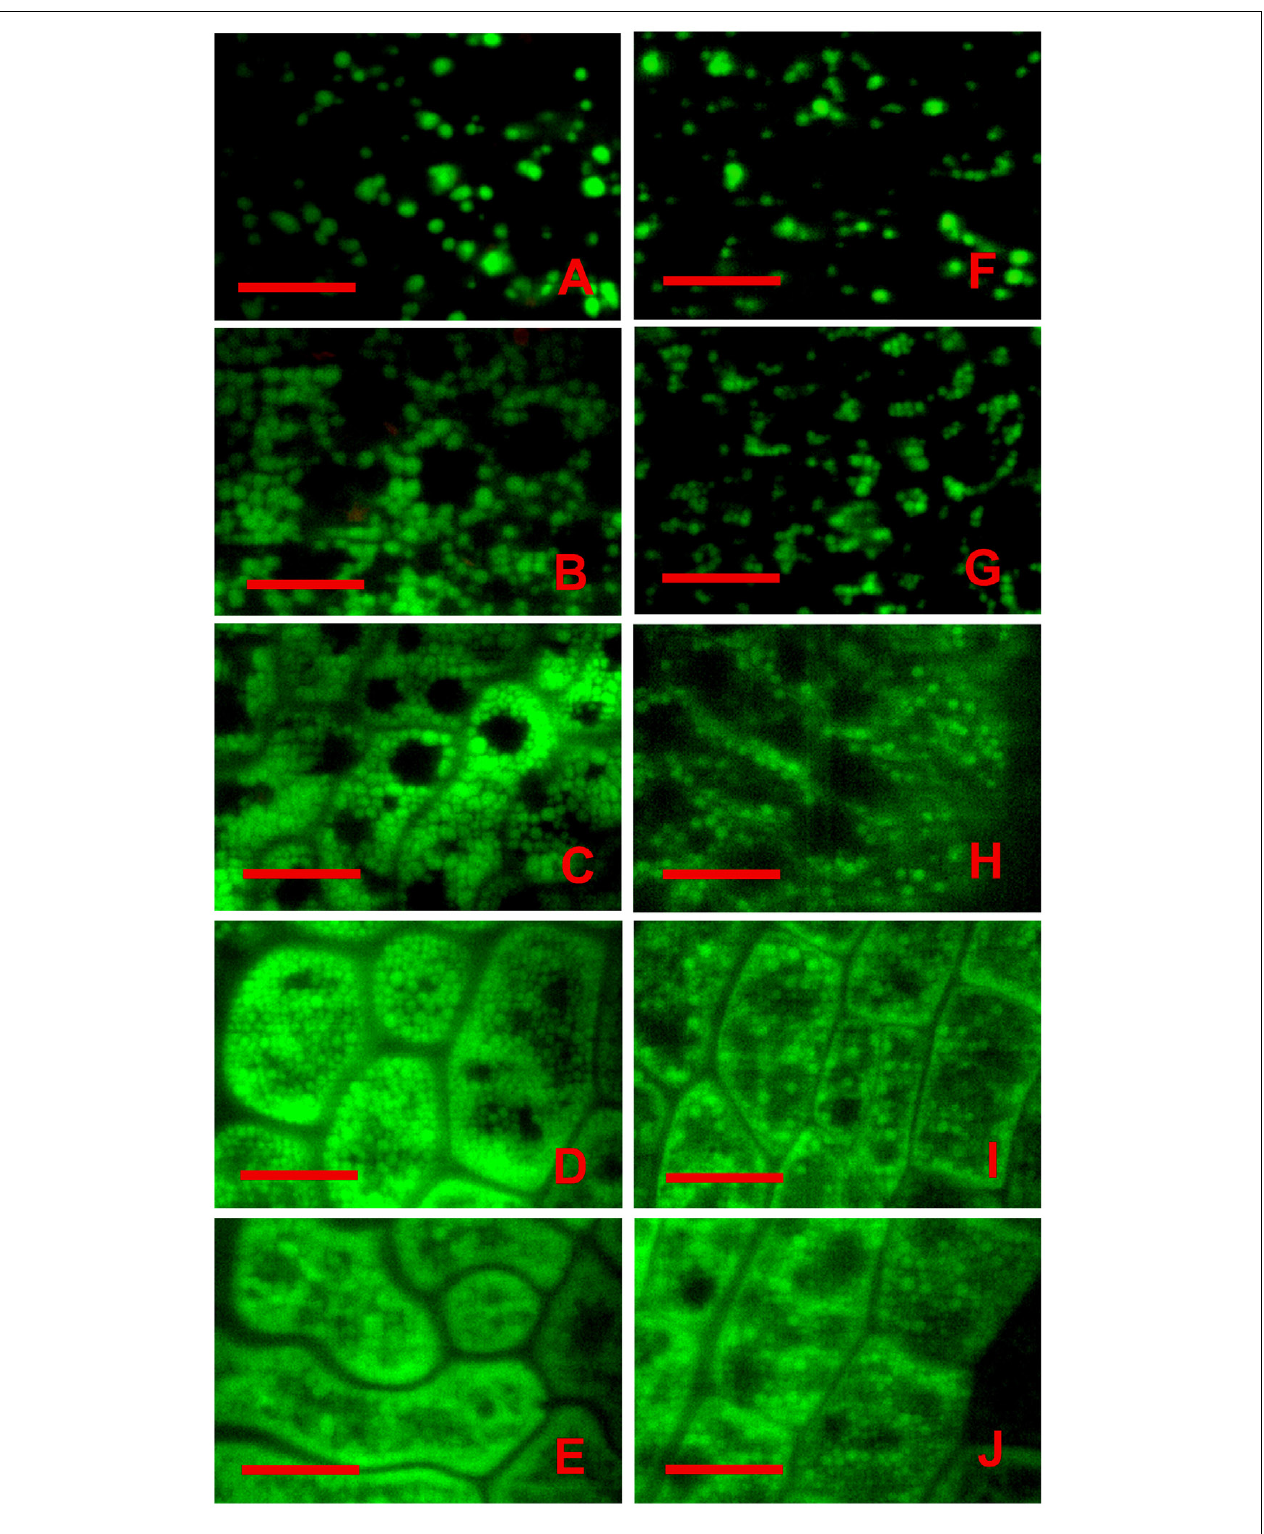
FIGURE 6 | Analysis of oil bodies using Nile red staining. Both the control (A–E) and tinfoil-enwrapped (F–J) embryos were stained with Nile red, and analyzed with a laser confocal microscope when they were grown for 6 (A,F) , 8 (B,G) , 10 (C,H) , 12 (D,I) , and 14 DAP (E,J) , respectively. The green fluorescence was emitted from oil bodies stained with Nile red, while the red fluorescence was emitted from chlorophyll in the chloroplast. Bar = 10 µ m.